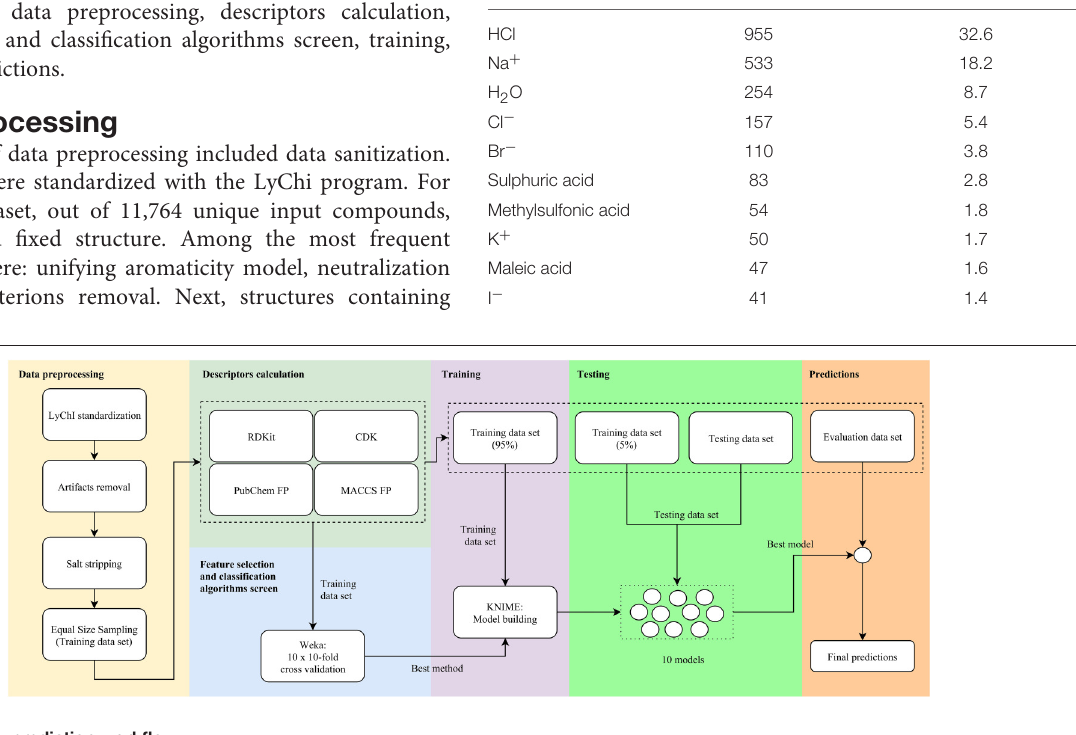
FIGURE 1 | Activity prediction